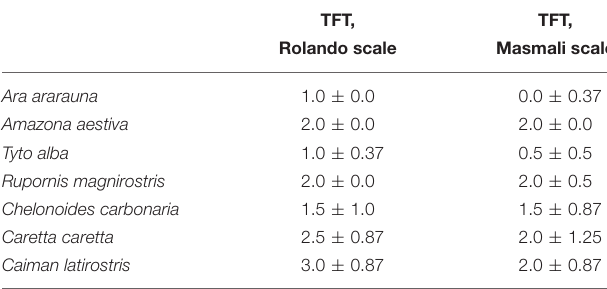
TABLE 2 | Median and semi-interquartile range for tear ferning test (TFT) of birds and reptiles.